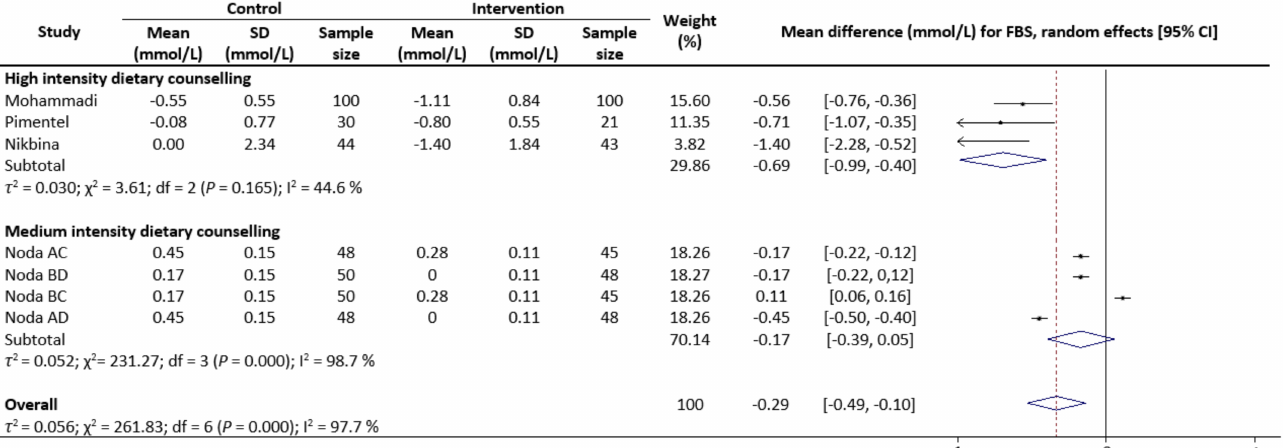
Figure 5. Random-effects model meta-analysis for comparing the changes in FBS of RCTs providing dietary counselling compared to not providing dietary counselling and subcategory analysis in accordance with the intensity level for dietary counselling. Each study is identified by author and year. The horizontal line represents the effect size for each study and the whiskers extending on both sides represent the study effect’s 95% CI. The diamond indicates the overall effect size. Abbreviations: AC, group A and group C; BD, group B and group D; BC, group B and group D; AD, group A and group